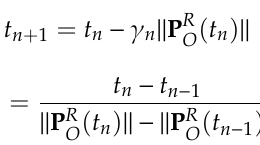
Figure 11. Context analysis flow chart.